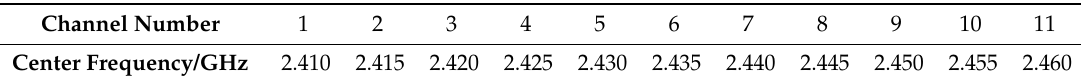
Figure 12. Corona discharge test. Table 1. 11 frequency channels of the RF